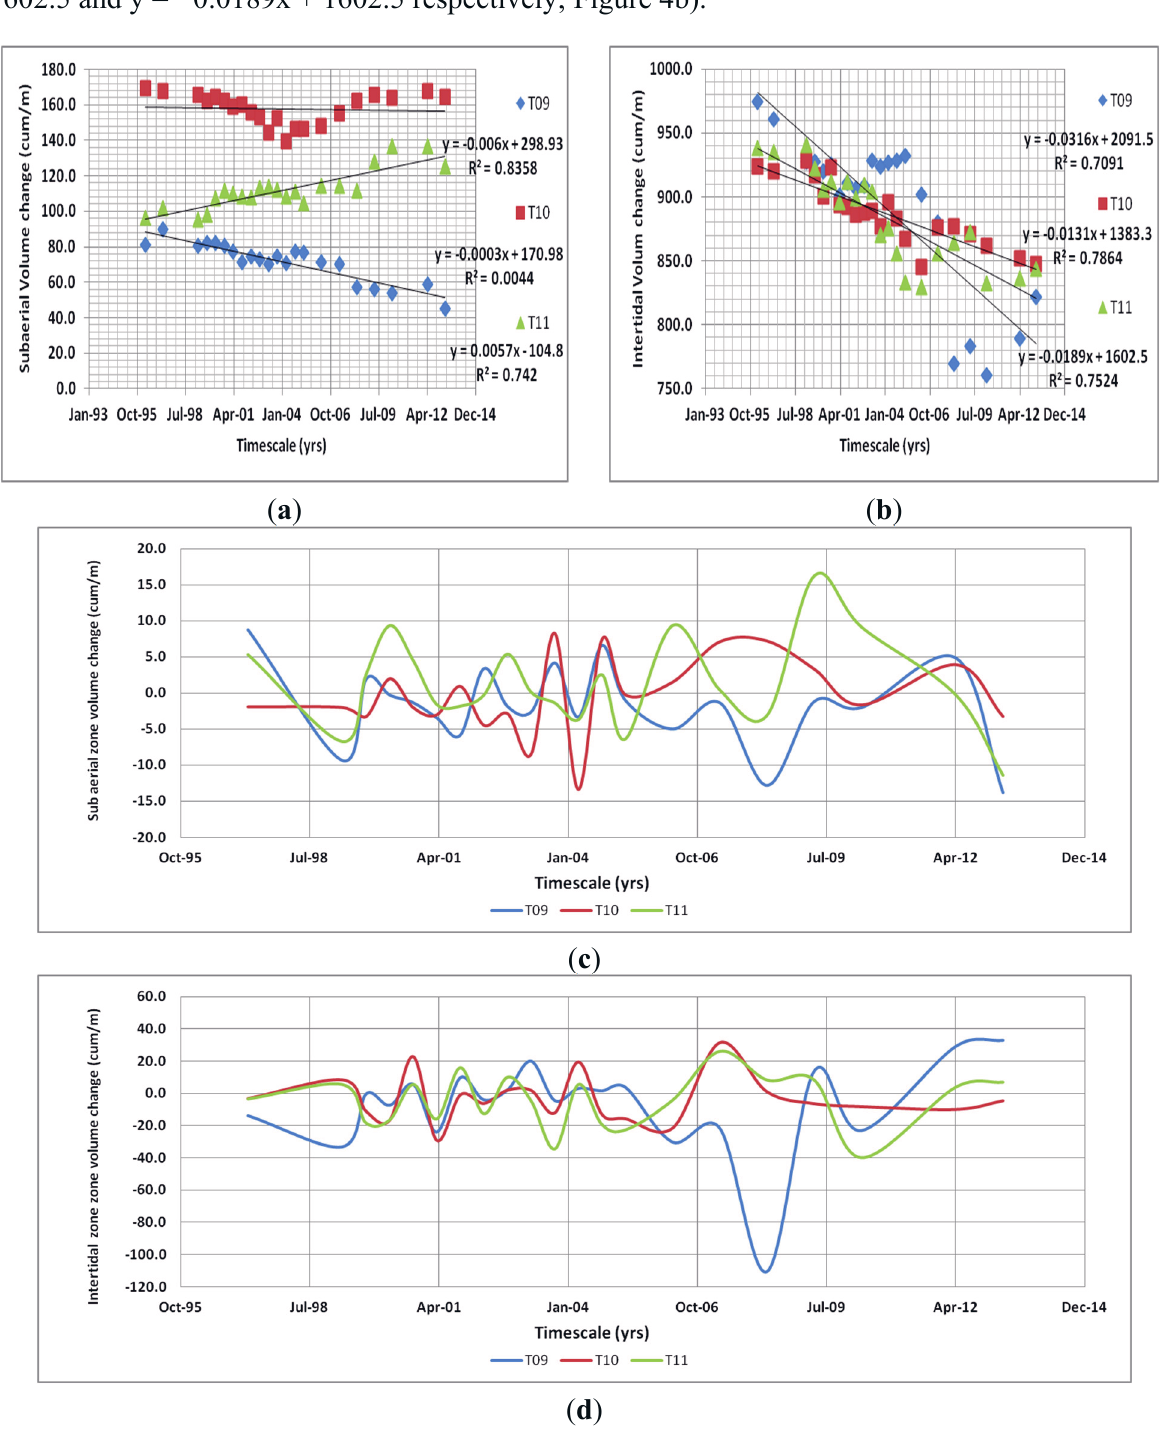
Figure 4. Analyses of beach volume trends between 1996 and 2013: ( a ) temporal subaerial volume change; and ( b ) temporal intertidal volume change. Graphical representations depicting temporal inter-survey volume change between 1996 and 2013: ( c ) subaerial zone; and ( d ) intertidal